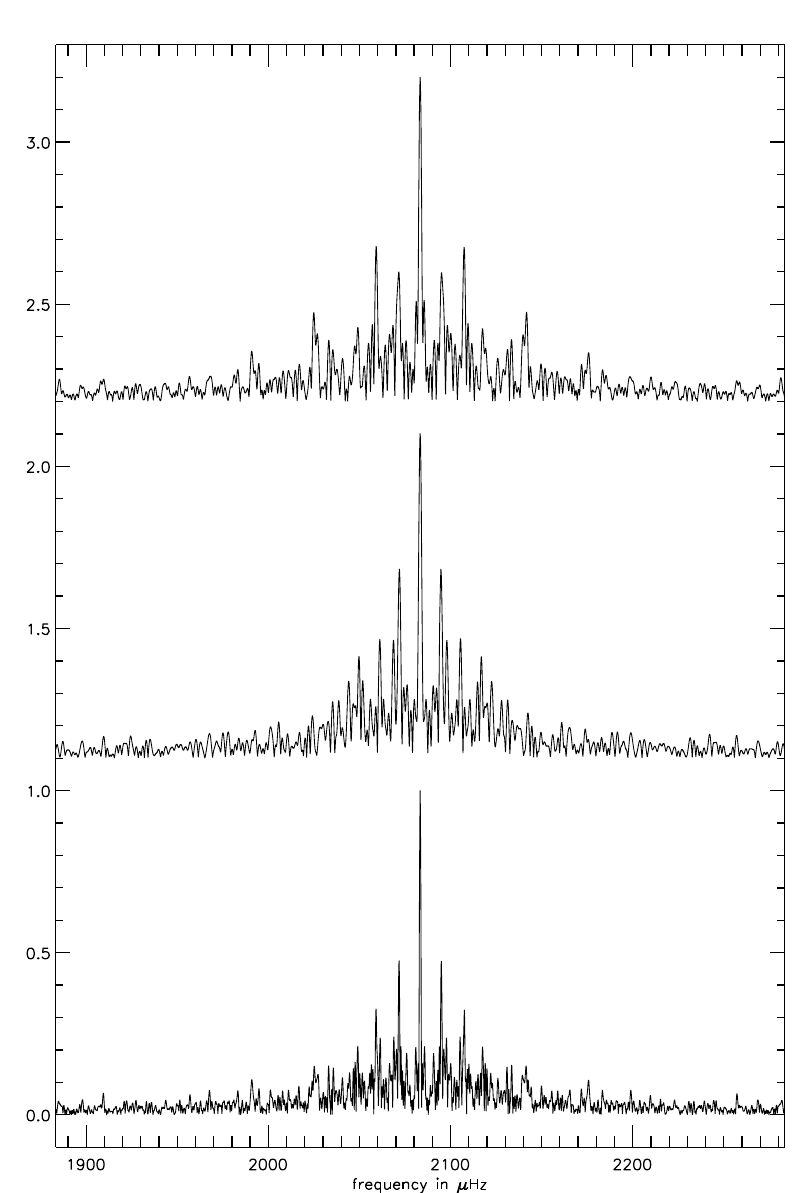
Fig. 3. Window functions for a sinusoid at 2083 µ Hz (corresponding to the main period), from top to bottom: first half, second half, full run. All functions are given in pseudo-amplitude units (square root of power spec- tral density), and are normalized to unity at the maximum peak height. The upper two are plotted with